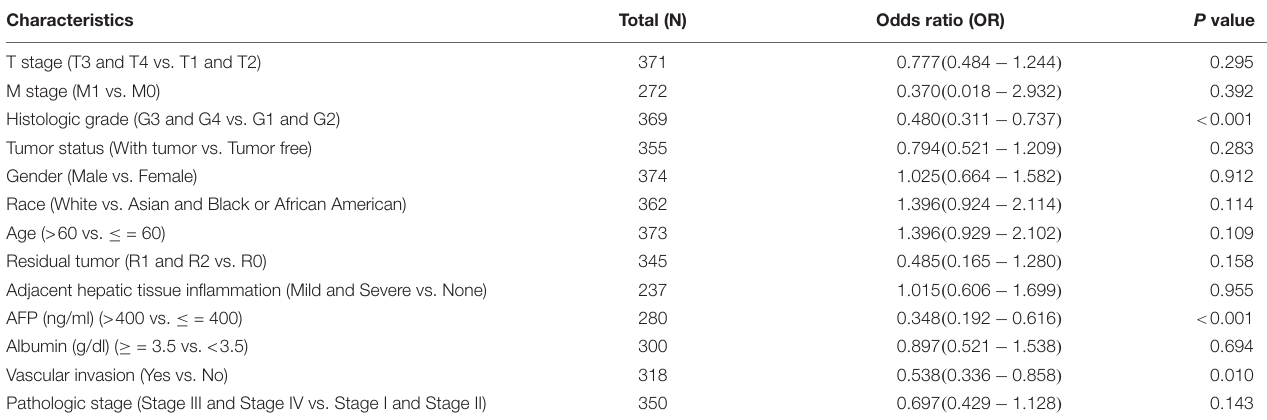
FIGURE 4 | STEAP3 overexpression inhibited the cell proliferation. (A) LIHC cells Huh7 and MHCC97H were transfected with pcDNA3.1 or pcDNA-STEAP3, after which STEAP3 were evaluated by western blot. (B,C) CCK-8 assay indicated the effects of STEAP3 overexpression on the cell proliferation rate of Huh7 and MHCC97H cells. (D,E) STEAP3 overexpression inhibited the cell colony formation rate of Huh7 and MHCC97H cells. * p < 0.05, ** p < 0.01. TABLE 2 | Association between clinical characteristic parameters and STEAP3 expression in LIHC patients from